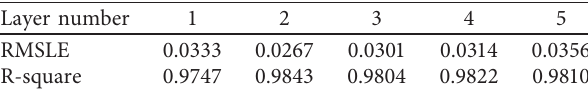
Table 4: The RMSLE and R-square of different layer models.